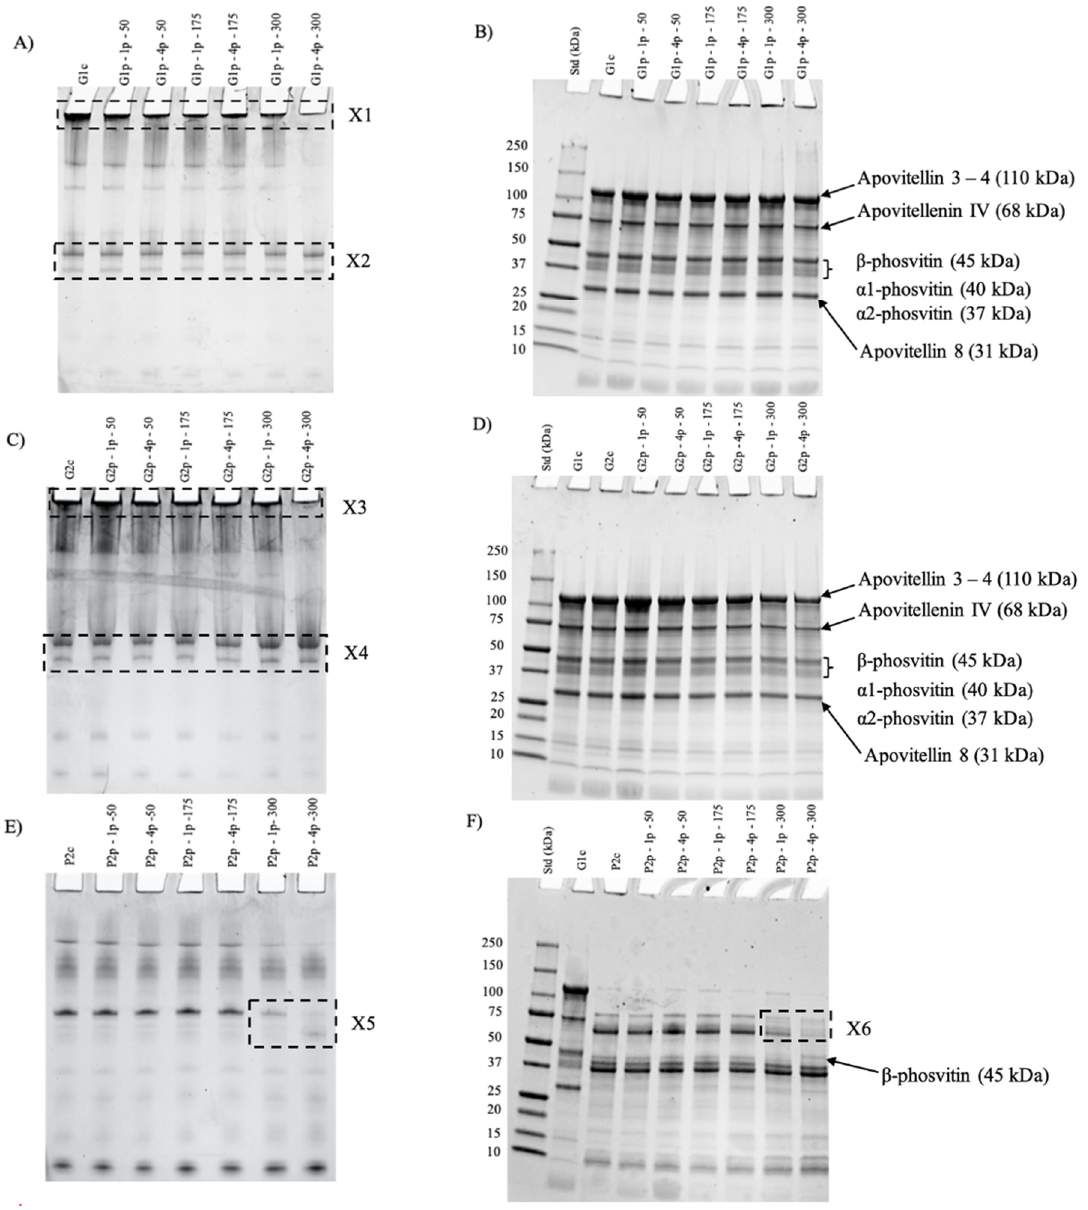
Figure 5. Native ( A , C , E ) and reduced ( B , D , F ) SDS PAGE of initial granule (G1c) and pressure- treated granule (G1p) ( A , B ); control granule from initial granule (G2c) and granule from pressure- treated granule (G2p) ( C , D ); and control plasma from initial granule (P2c) and plasma from pres- sure-treated granule (P2p) ( E , F ). granule (P2p) ( E , F